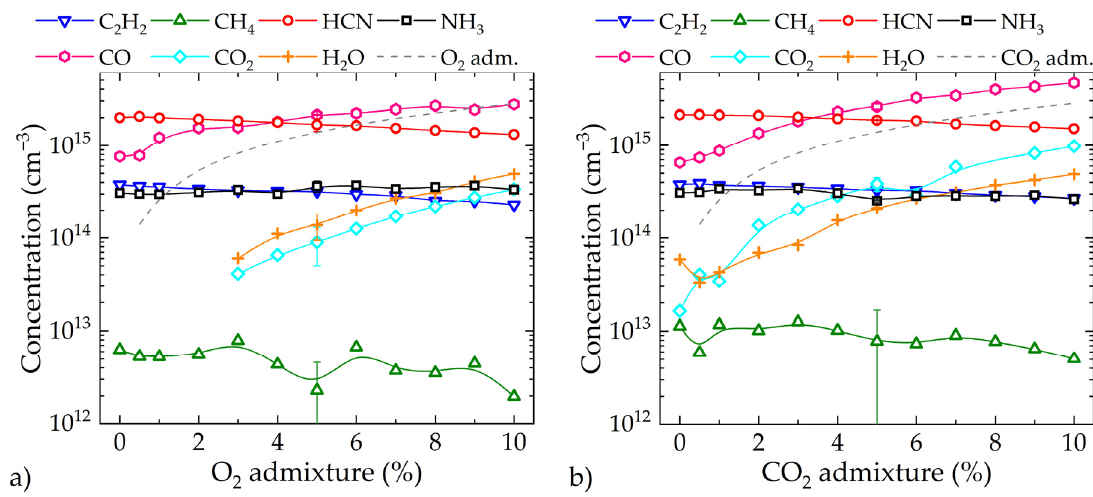
Figure 1. Concentrations of C 2 H 2 , CH 4 , HCN, NH 3 , CO, CO 2 , and H 2 O as functions of ( a ) O 2 and ( b ) CO 2 admixture. T = 540 ◦ C, N 2 + O 2 = 90% or N 2 + CO 2 = 90%, H 2 = 10%, P AS = 6.0